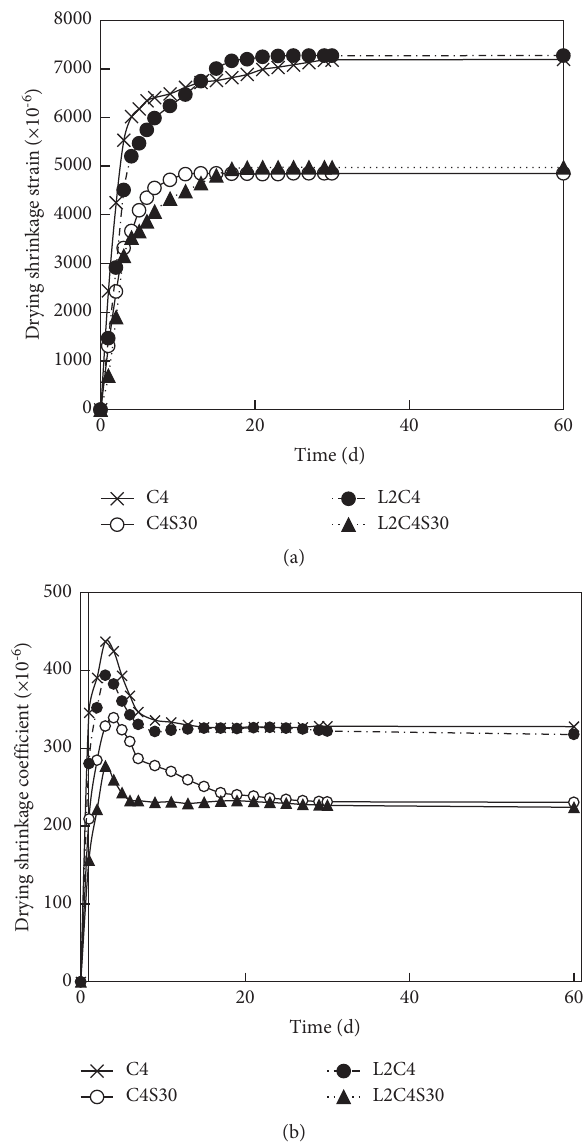
Figure 9: Relationship between the time and drying shrinkage strain/coefficient.